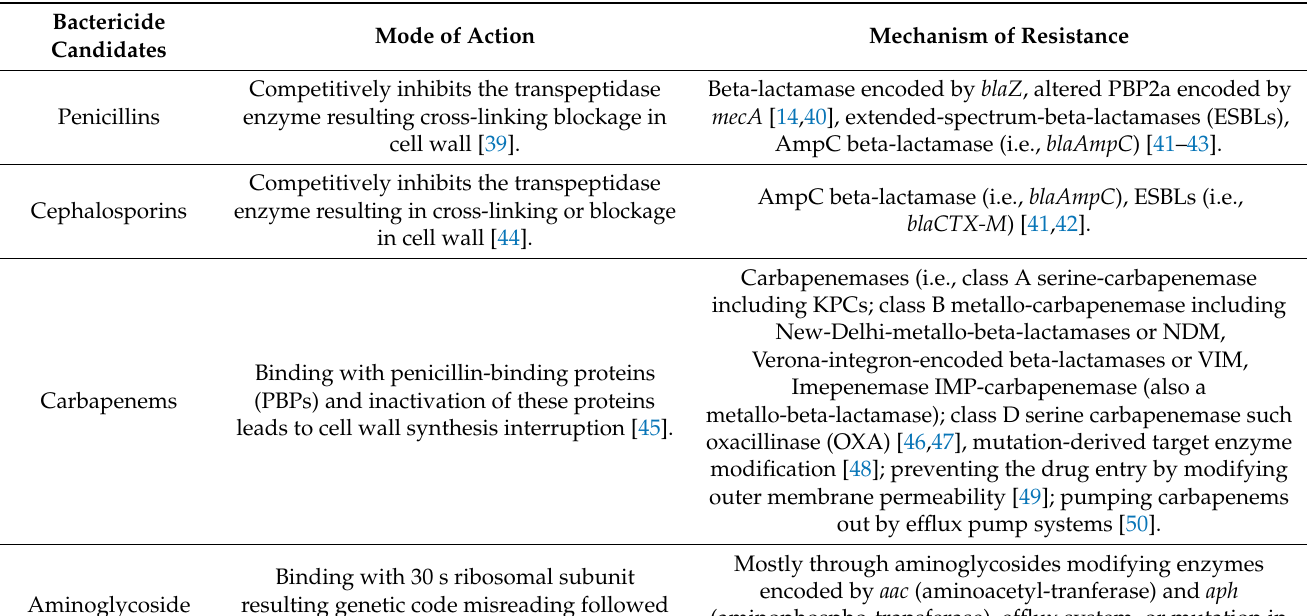
Table 2. Action and common resistance mechanisms of major bactericidal